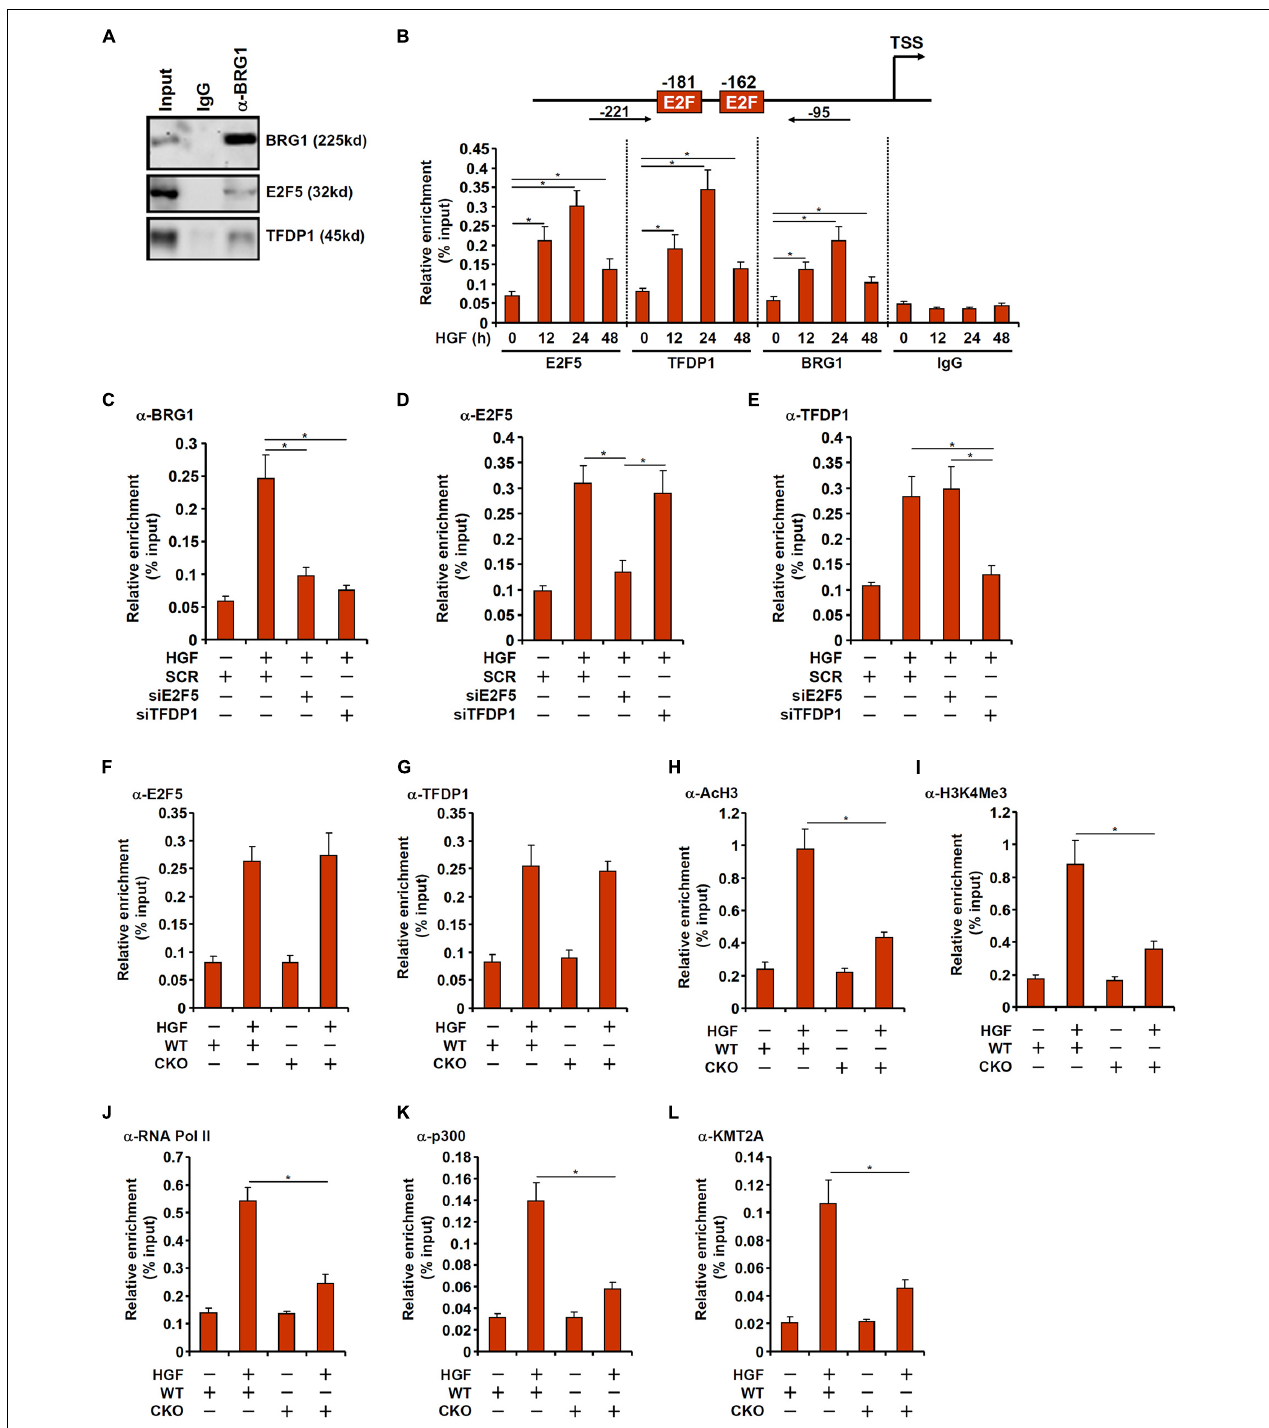
FIGURE 4 | BRG1 interacts with E2F5-TFDP1 to activate MYCN transcription. (A) Immunoprecipitation was performed with anti-BRG1 or IgG using primary murine hepatocyte lysates. (B) Primary murine hepatocytes were treated with HGF and harvested at indicated time points. ChIP assays were performed with anti-BRG1, anti-E2F5, anti-TFDP1, or IgG. Upper panel, a scheme of the MYCN promoter highlighting the positions of the two proximal E2F sites and the ChIP primers. TSS, transcription start site. (C–E) Primary murine hepatocytes were transfected with indicated siRNAs followed by treatment with HGF. ChIP assay was performed with anti-BRG1, anti-E2F5, and anti-TFDP1. (F–L) Primary hepatocytes were isolated from WT and BRG1 CKO mice followed by treatment with HGF. ChIP assays were performed with anti-E2F5, anti-TFDP1, anti-acetyl H3, anti-trimethyl H3K4, anti-RNA polymerase II, anti-p300, and anti-KMT2A. Data are expressed as mean ± standard deviation (SD). * p < 0.05 (one-way ANOVA with post hoc Scheffe test).